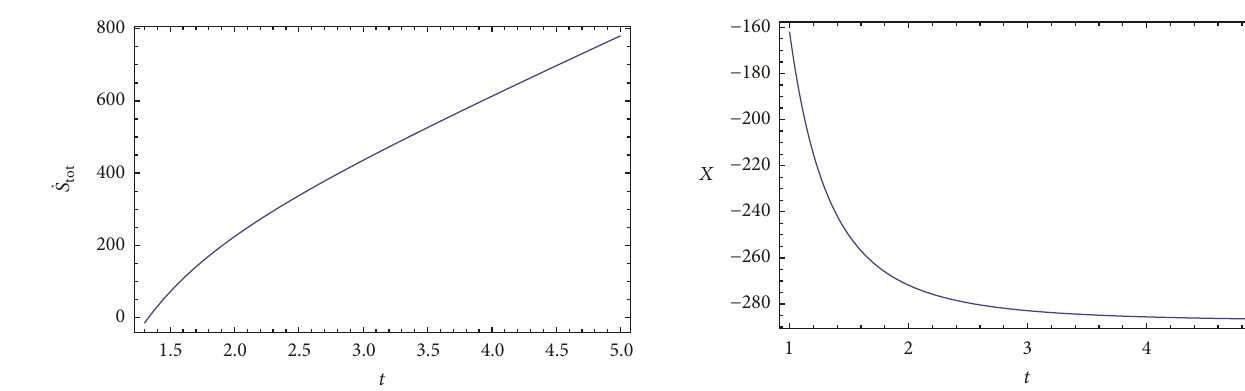
̈𝑆 tot by taking power law entropy as entropy